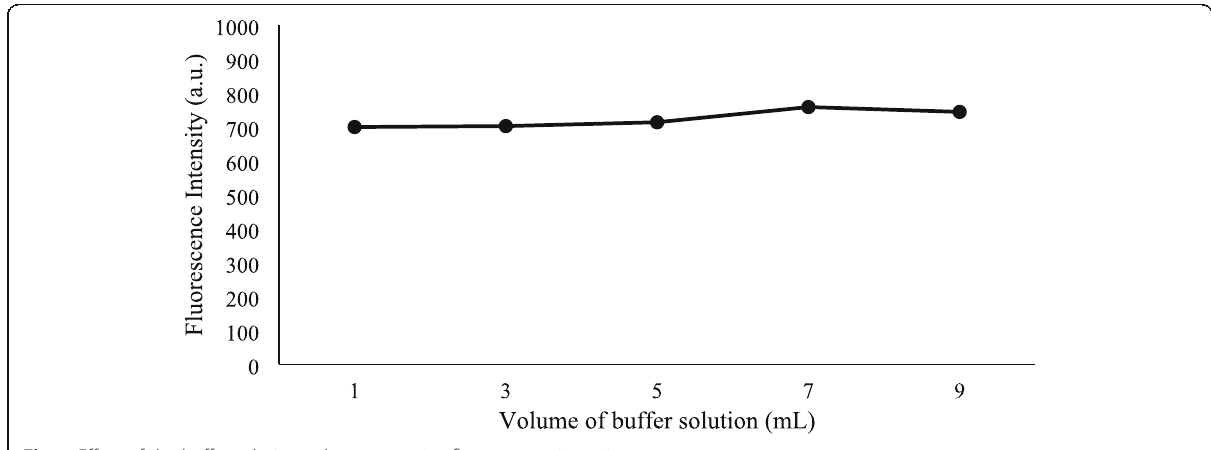
Fig. 4 Effect of the buffer solution volume on native fluorescence